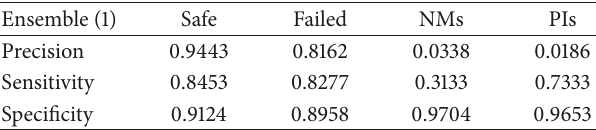
Table 9: Locally weighted ensemble performance parameters using (12).